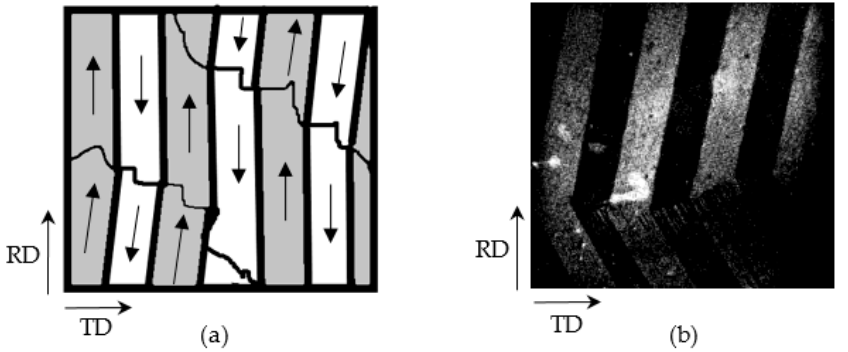
Figure 4. Expected magnetic domain pattern for a GOES. ( a ) Sketch of the domain orientation around the grains boundaries; ( b ) image of the domain orientation around the boundary between two grains of a (110)[001] FeSi sample [41] (p. 1091).